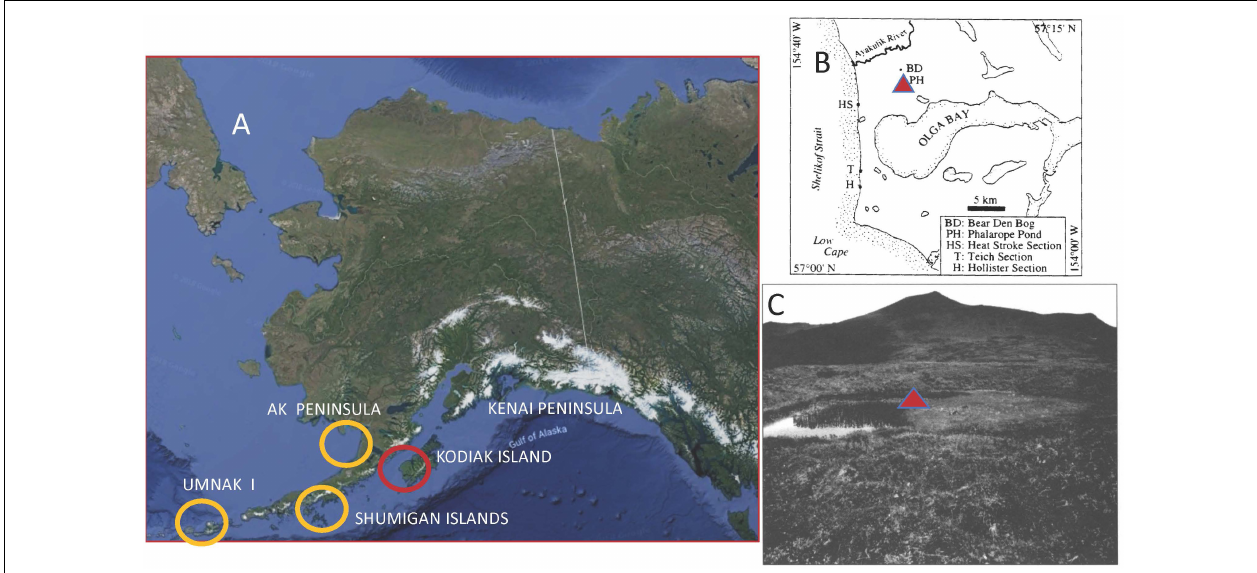
FIGURE 1 | Location of Phalarope Pond, western Kodiak Island, Alaska, with regional sites and photo of the coring site. (A) Core site location on western Kodiak and neighboring comparative sites. (B) Phalarope Pond (PH) core site north of Olga Bay, western Kodiak Island. (C) Photo of Phalarope Pond, Kodiak Island with core site